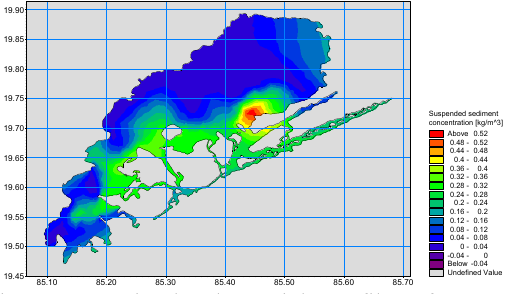
Figure 7a. Simulated spatial profile of Suspended Sediment concentration (kg/m 3 )